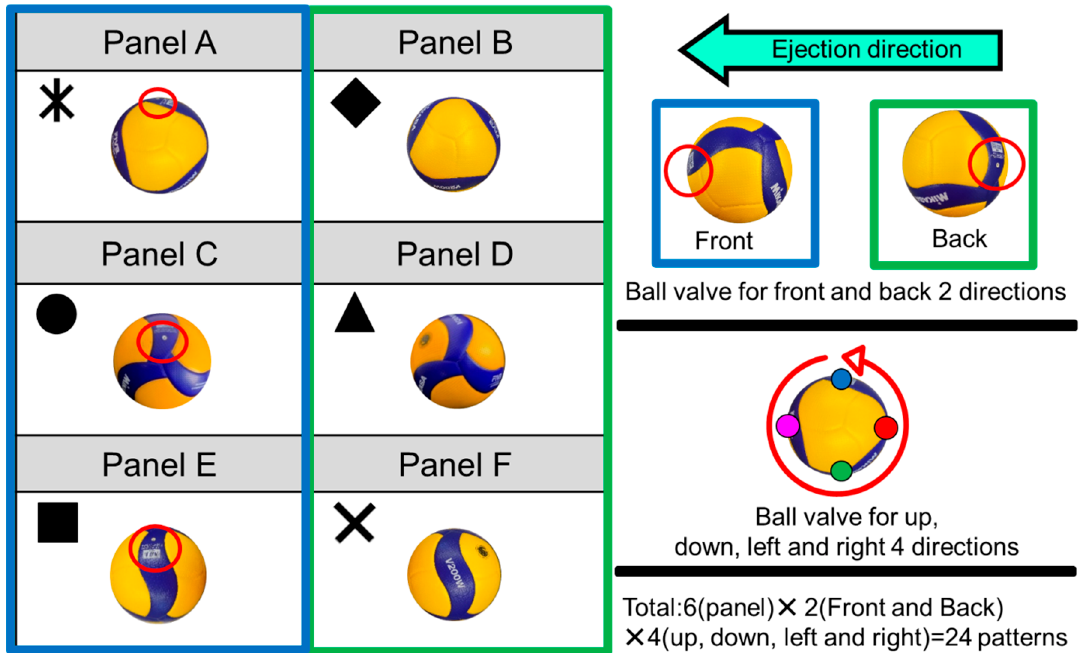
Figure 13. Relationship between ball orientation and ball valve at the time of ejection.